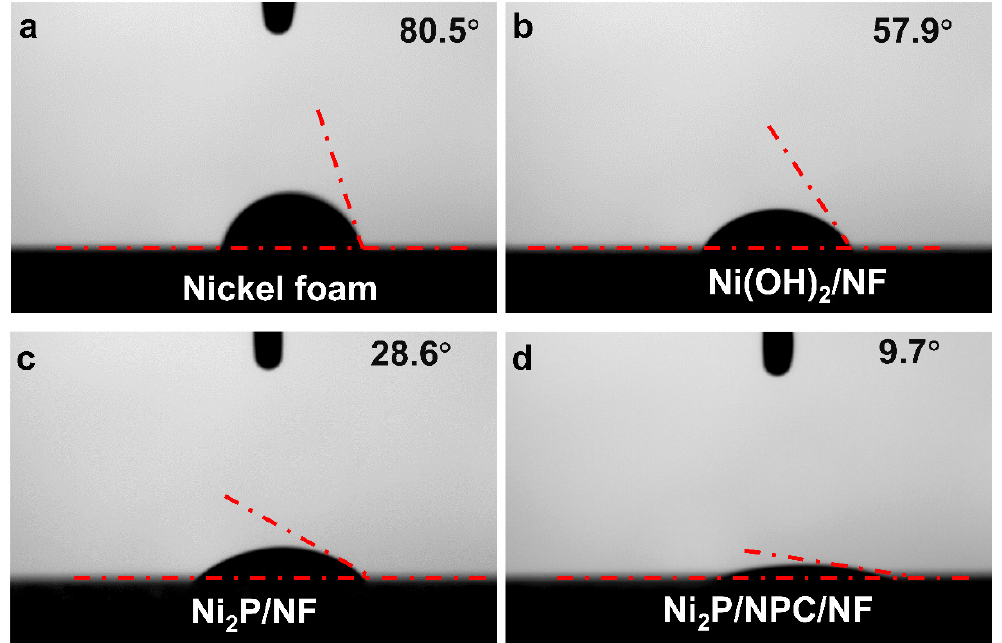
Figure 4. Hydrophilic test in KOH solution of ( a ) bare nickel foam, ( b ) Ni(OH) 2 /NF, ( c ) Ni 2 P/NF and ( d ) Ni 2 P/NPC/NF.